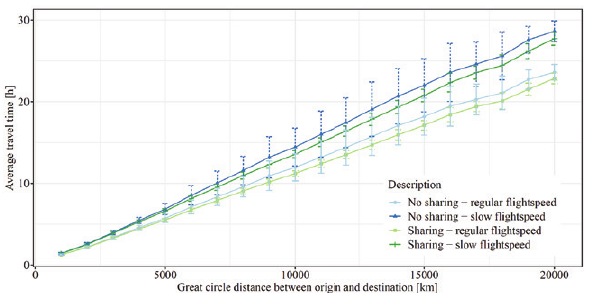
Figure 7. Infl uence of business model and fl ight speed on average travel time of the itinerary